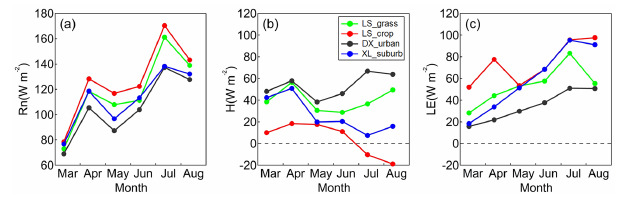
Figure 8. Monthly variation in (a) net radiation, (b) sensible heat flux, and (c) latent heat flux at the four sites in Nanjing from March to August 2013.